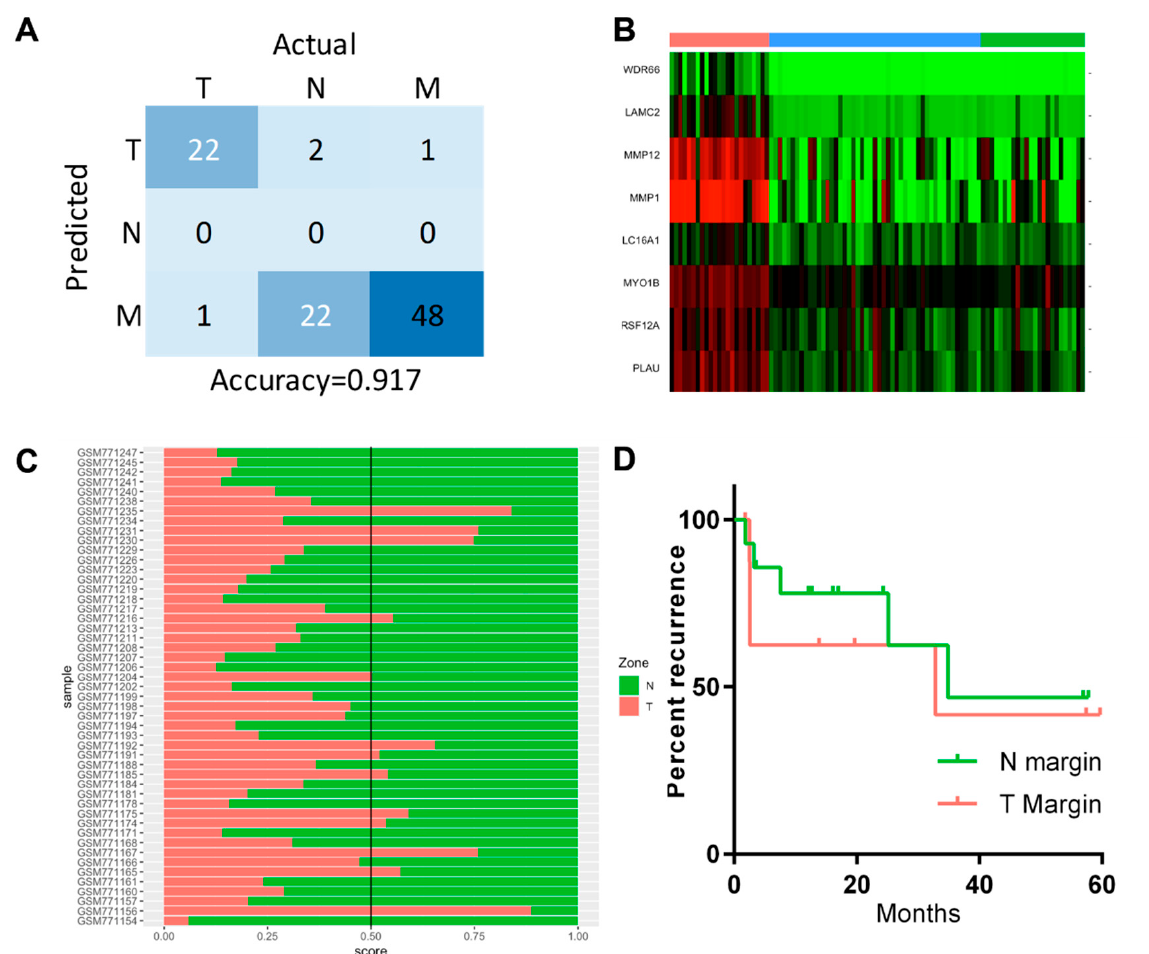
Figure 5. Testing sPLS-DA models in the validation data. ( A ) Confusion matrix of 3 zone predictions of the validation dataset using the classifiers from Figure 1. ( B ) Heatmap of the expression of T vs. N prediction model classifiers in the validation dataset. ( C ) Prediction score plot of the validation margins using the binary classifier for T vs. N in the validation data. ( D ) Survival plot for tumour recurrence for patients with primary margins predicted as T or N.